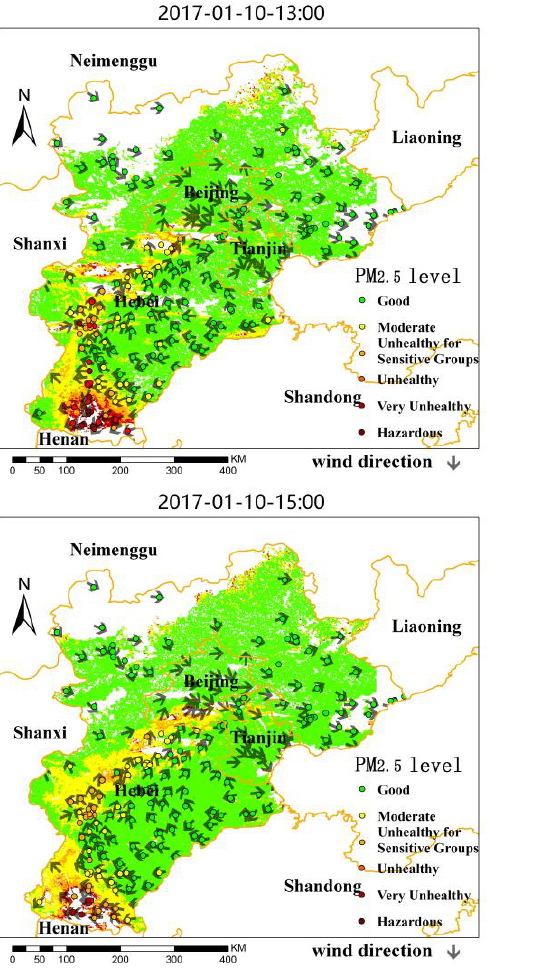
Figure 11. Hourly PM 2.5 concentrations of satellite-retrieved and ground-measured from 09:00 to 16:00 on 10 January 2017, in Hebei.